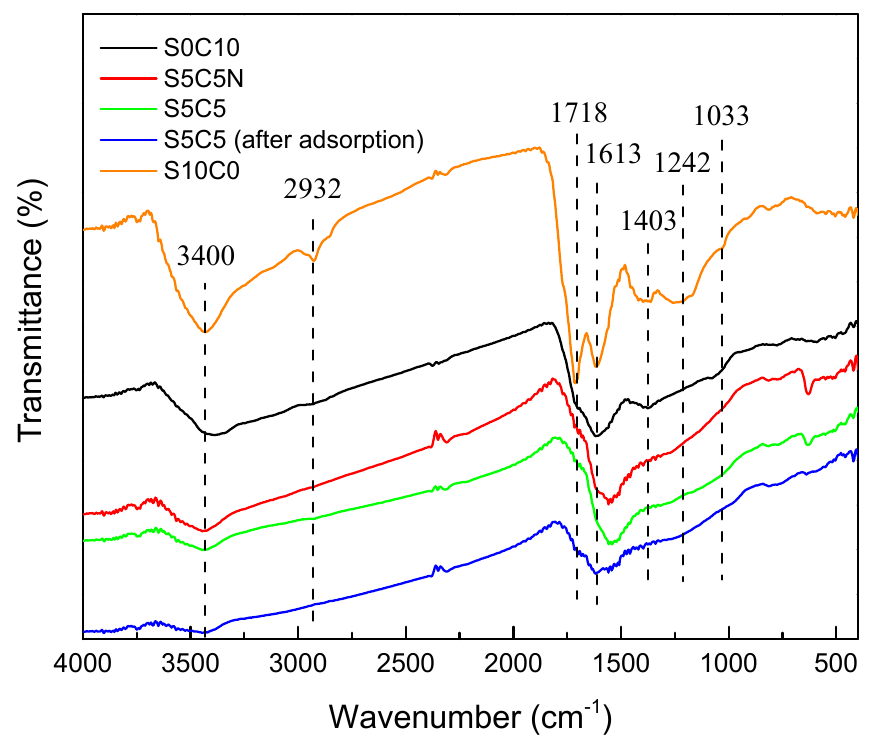
Figure 2. FT-IR spectra of the hydrochars.